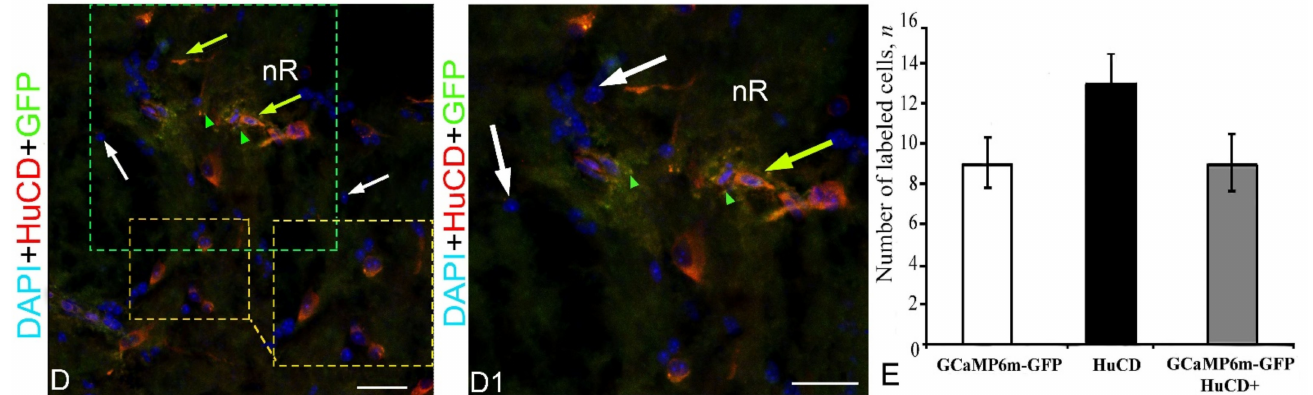
Figure 11. Z-stacks showing DAPI staining, localization of GFP and HuCD, and their colocalization in the nucleus rotundus of juvenile chum salmon, O. keta , at 90 days after a single injection of the rAAV into the cerebellar body. ( A ) DAPI staining with a pictogram showing the nucleus rotundus area in a red box; the dotted white square outlines a cluster of DAPI-stained nuclei; the white dotted oval outlines the fragments of DAPI-stained vessels. ( A1 ) The enlarged fragment outlined by a white dotted box in A; DAPI-stained nuclei (white arrows); nR, nucleus rotundus . ( B ) Expression of GFP in the populations (1–3) of neurons and nucleus rotundus granules. ( B1 ) The enlarged fragment outlined by a yellow dotted box in B; GFP+ neurons (green arrows) and GFP+ granules (green arrowheads). ( C ) Immunofluorescence of HuCD protein in populations of nucleus rotundus neurons; inset for population 2 with a red dotted line. ( C1 ) The enlarged fragment outlined by a yellow dotted oval in C; HuCD+ neurons (red arrows). ( D ) Optical overlay of three DAPI/GFP/HuCD staining channels showing areas of GFP/HuCD co-localization in neurons (yellow arrows) and in GFP+ granules, DAPI-stained nuclei (white arrows); enlarged neurons in the population are outlined by yellow dotted lines (inset). ( D1 ) The enlarged fragment outlined by a green dotted oval; for designations, see ( D ). Laser scanning confocal microscopy. Scale bar: ( A , B , C , D ) 50 µ m; ( A1 , B1 , C1 , D1 ) 20 µ m. ( E ) One- way ANOVA showing the relative distribution of GFP and HuCD immunolabeled cells (M ± SD) in the nucleus rotundus in juvenile chum salmon, O. keta . No significant intergroup differences in GCaMP6m-GFP and HuCD, GCaMP6m-GFP and GCaMP6m-GFP/HuCD+ were found ( n = 5 in each